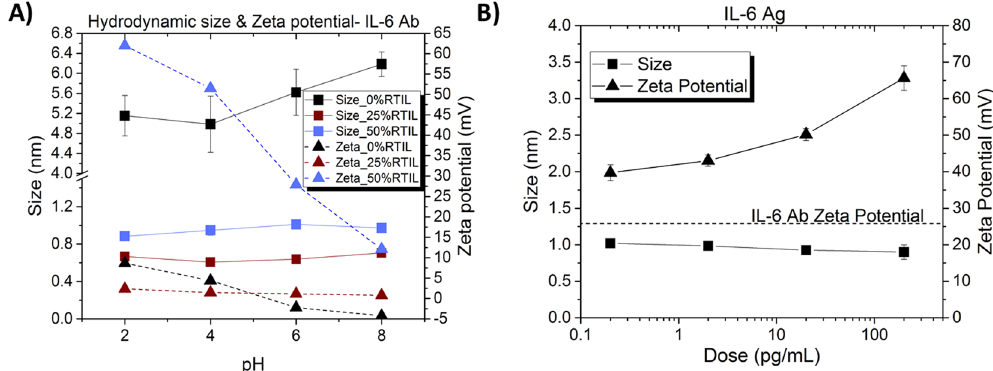
Figure 6. DLS and zeta potential measurements. ( A ) α -IL-6 antibody spiked in synthetic sweat (SS) of varying pH and RTIL ratios; ( B ) IL-6 antibody-antigen interactions in 50% RTIL in SS solutions. The dotted line in ( B ) represent the zero dose antigen zeta potential value for the respective